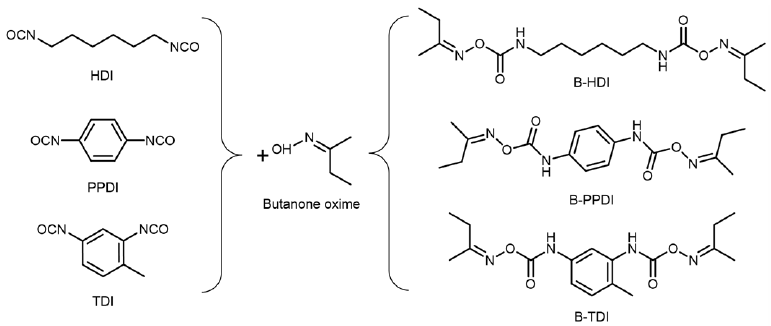
Figure 8. Tan δ -T curves of SBR/S/silica, SBR/S/Si69/silica, and SBROH x /silica composites. Blocked hexamethylene diisocyanate (B-HDI); 1,4-Phenylene diisocyanate (B-PPDI); and toluene-2,4-diisocyanate (B-TDI) were synthesized (Scheme 3) using butanone oxime. The distance between the two NCO groups for these three diisocyanates increased sequen- tially. The blocking reaction was complete, as the peak at 2270 cm − 1 assigned to NCO groups in TDI disappeared after the reaction (FTIR spectra, Figure S6).